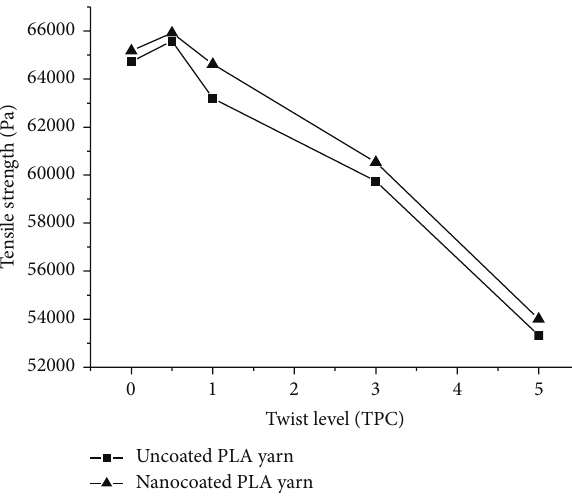
Figure 10: Tensile strength of uncoated and nanocoated PLA yarns at different twist